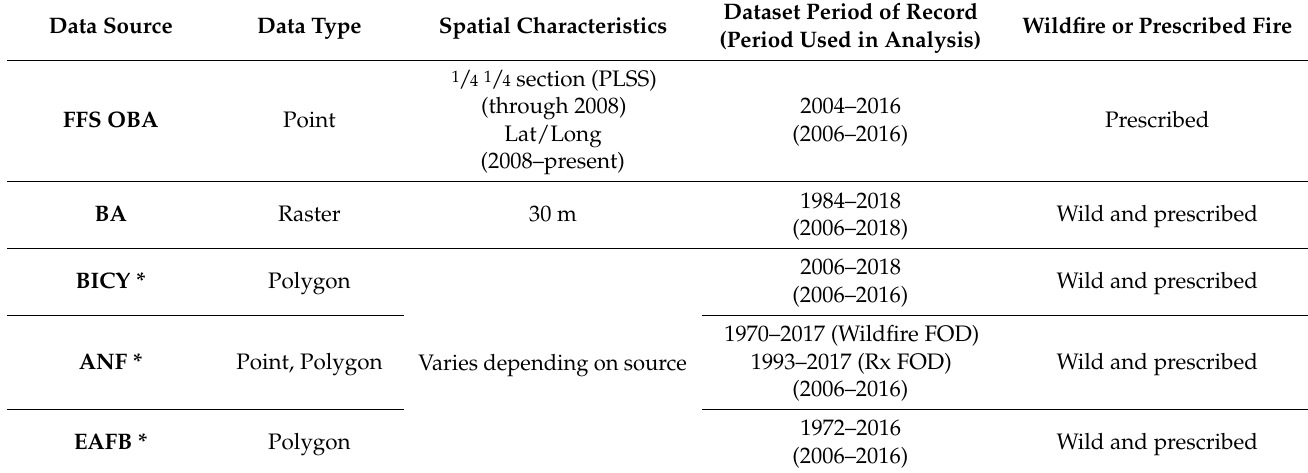
Table 1. Datasets evaluated for mapping fires in Florida including spatial and temporal characteristics (update availability, period of record, and data coverage timeframe) pertinent to this project. ANF: Apalachicola National Forest, BA: Landsat Burned Area products, BICY: Big Cypress National Preserve, EAFB: Eglin Air Force Base, FFS OBA: Florida Forest Service Open Burn Authorizations, FOD: Fire occurrence database, PLSS: Public Land Survey System, and Rx: prescribed fire. * indicates landowner-provided